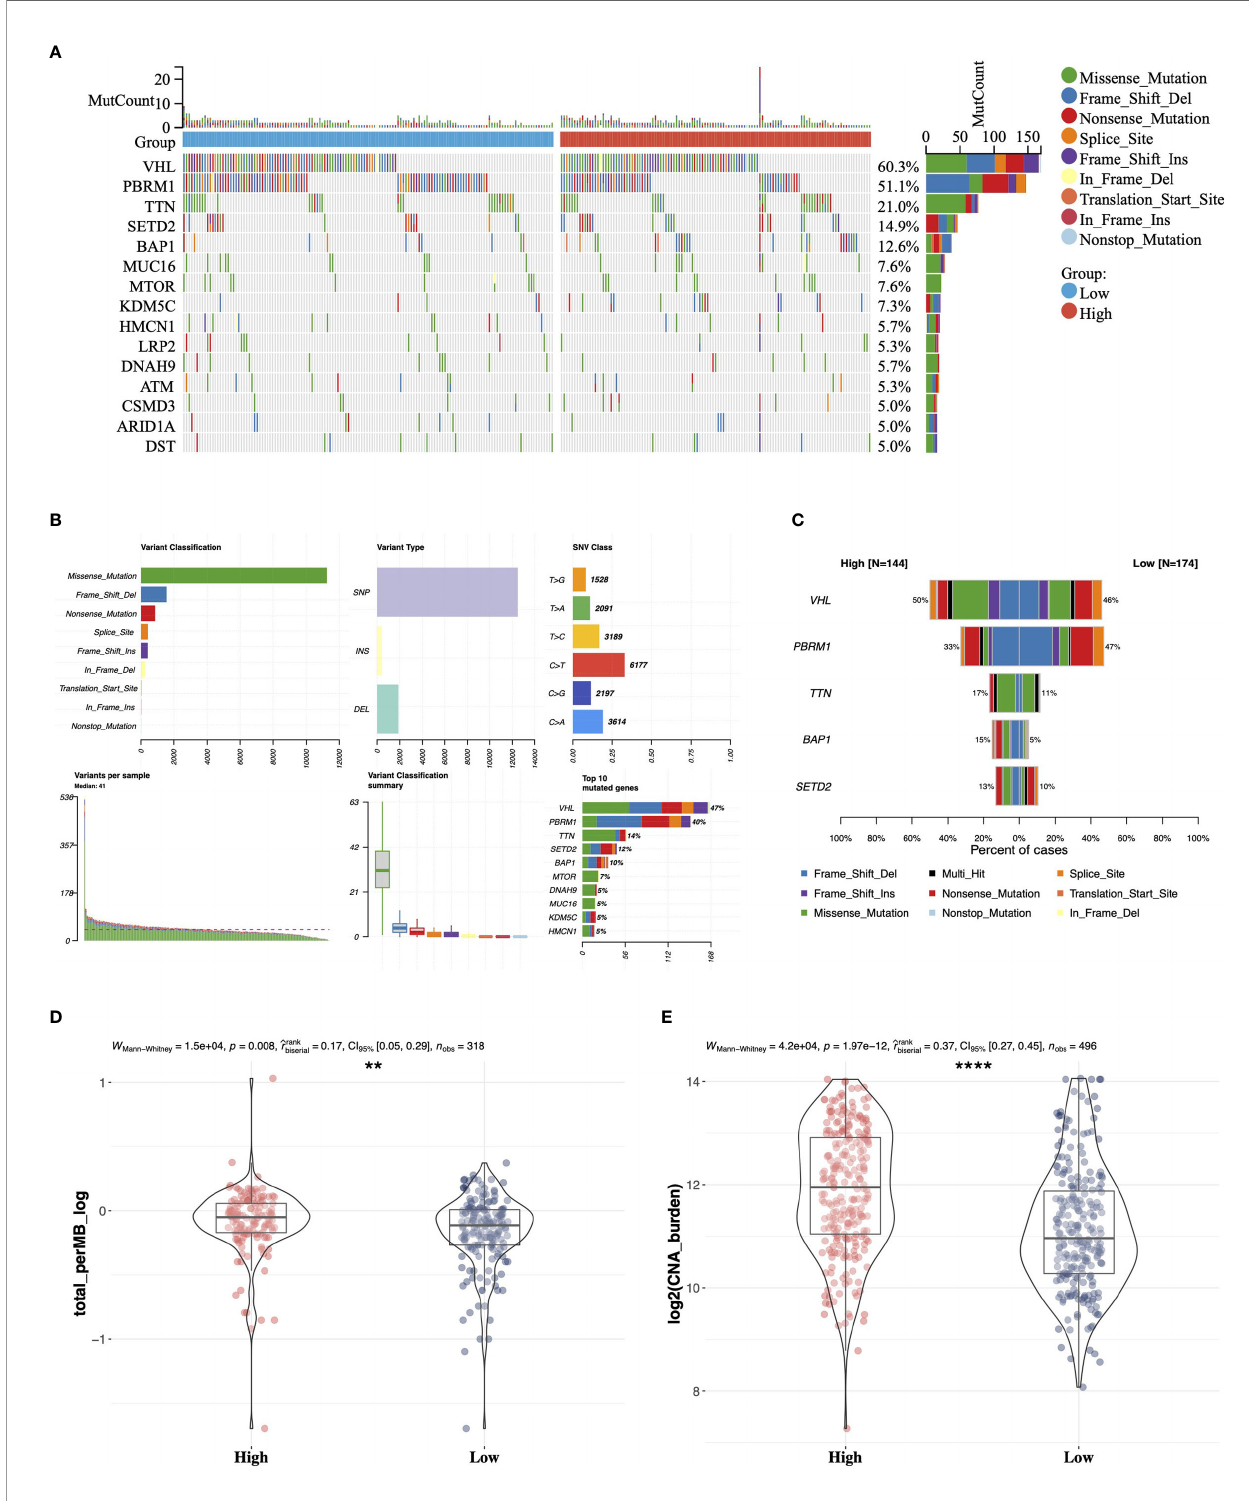
FIGURE 5 | Somatic variant analysis between high- and low-risk groups in TCGA. (A) Top 15 mutated genes in high- and low-risk groups. (B) Landscape of somatic mutations in TCGA-KIRC cohort. (C) Comparison of top fi ve mutated genes in high- and low-risk groups. Differences in tumor mutation burden (D) and copy number alteration burden (E) between the high- and low-risk groups ** 0.001 < p < 0.01; ****p <